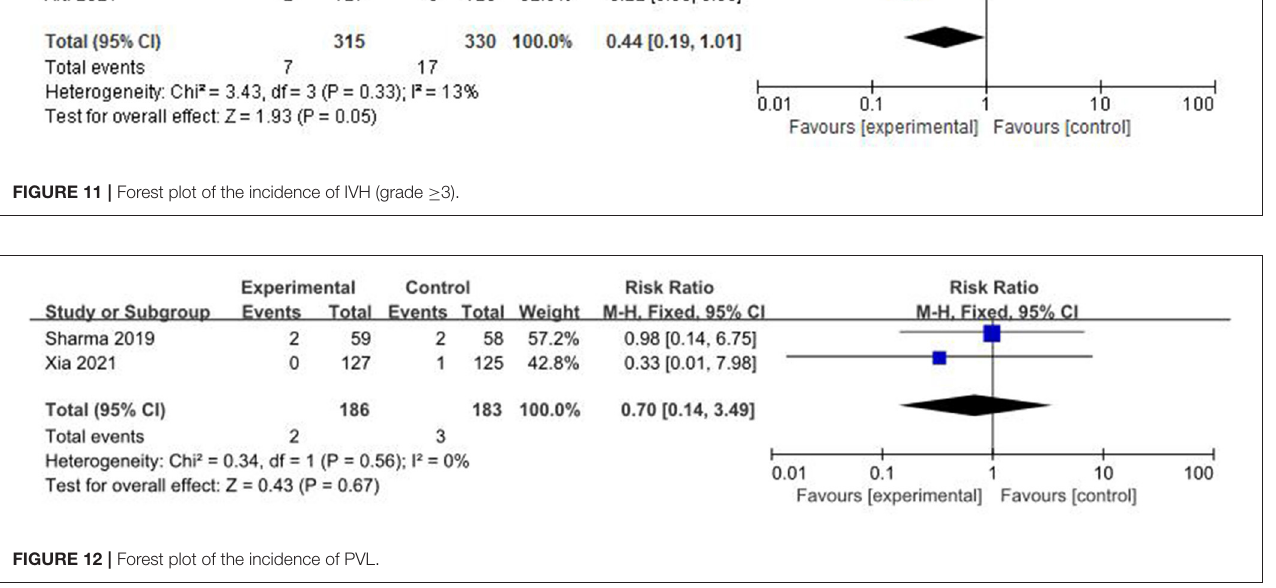
FIGURE 12 | Forest plot of the incidence of PVL.